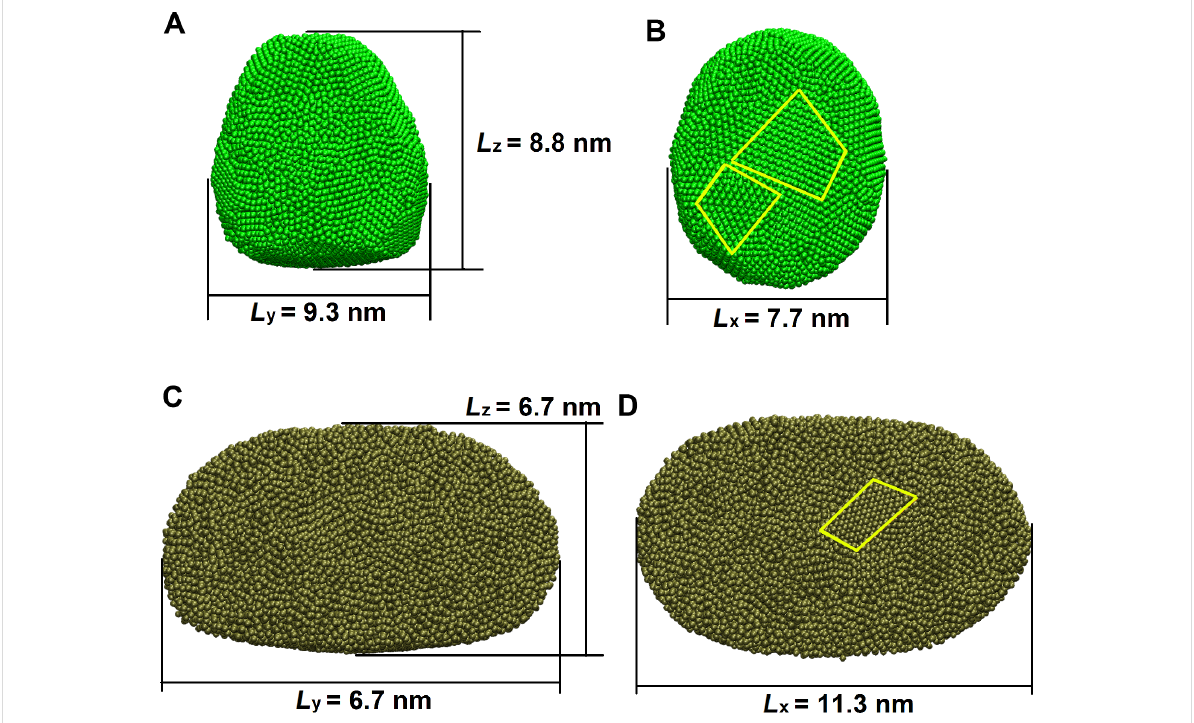
and from 20 nm 2 to 50 nm 2 for Cu. The shear stress depending on the contact area of Au nanoparticles varies from 55 MPa to 95 MPa and from 60 MPa to 120 MPa for Cu. The contact area for shear stress measurement is the same as for friction force measurements. Thus, for all six kinds of investigated nanoparti- cles friction force and shear stress as a function of contact area change within these orders of magnitude. Only for Cu the linear approximation of friction force as a function of the contact area decreases and the linear approximation of shear stress as a func- tion of A only decreases for Al. All other analogous approxima- tions are